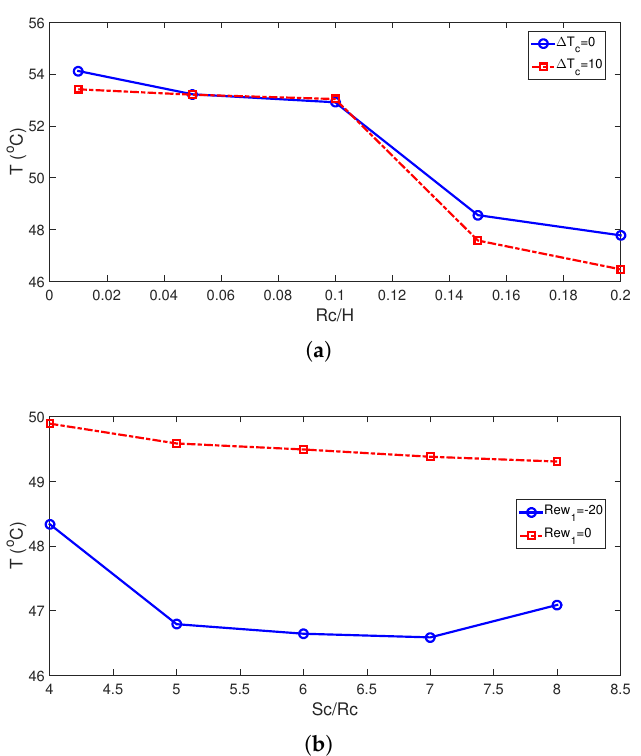
Figure 8. Average PST variations for different RCC sizes (Sc = 6Rc, ( a )) and for various distances between the cylinders (Rc = 0.1H, ( b )) ( ( Rew 1 ,Rew 2 ) = ( − 20, − 20 ) , ∆ T = 10, SVF =